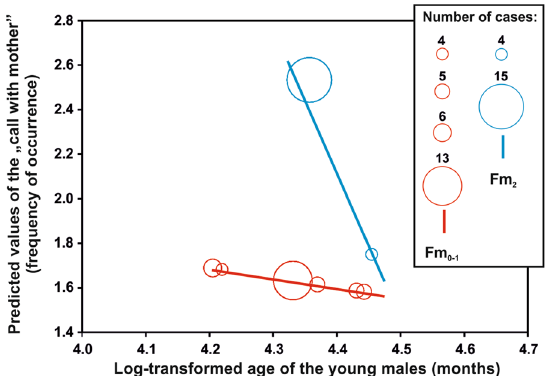
Figure 5. Predicted values of the “call with mother” (frequency of occurrence), i.e. production of female-like great calls by young males in co-singing interactions with their mothers plotted against the log-transformed age (months) of young males. Values for each cases are categorized according to the following forms of the multi-modulation phrase: Fm 0-1 —a non-mature form of the multi-modulation phrase, which contains one or no frequency modulation in the second note of the multi-modulation phrase; and Fm 2 —a mature form of the multi-modulation phrase, which contains two or more frequency modulations in the second note of the multi- modulation phrase.